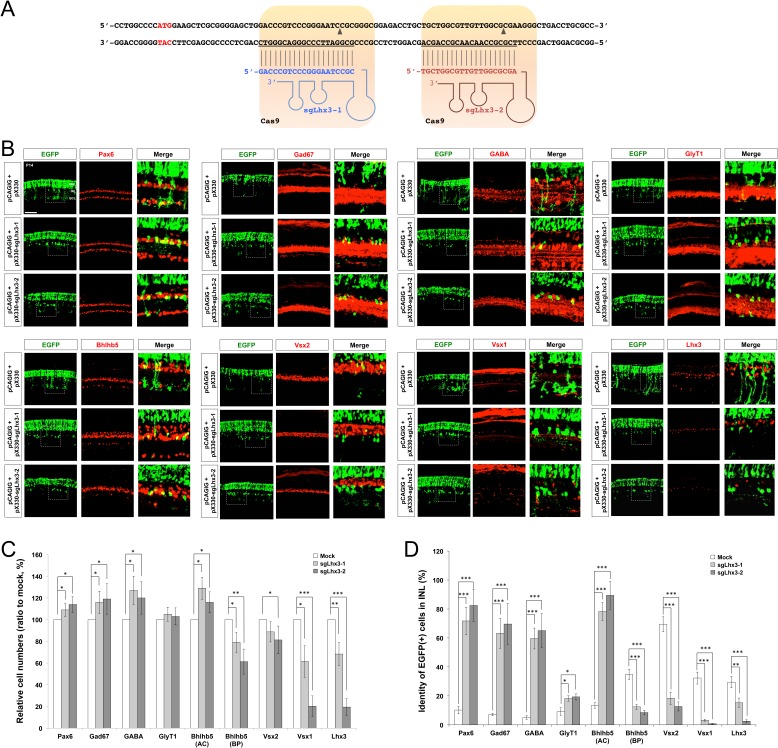
Deletion of Lhx3 in the post-natal mouse retina.(A) To delete Lhx3 in the post-natal mouse retina, we designed two independent sgRNAs complementary to the sequences near the translation initiation site in the exon2 (highlighted in red), following the suggestion of the CRISPR Design server (http://crispr.mit.edu). The sequences were cloned into pX330 (pX330-U6-Chimeric_BB-CBh-hSpCas9) DNA construct, which express the cloned sgRNA and Cas9 endonuclease. (B) P14 mouse retinas, which were electroporated with the indicated pX330 DNA constructs at P0, were stained for the detection of various amacrine cell markers, including Pax6 (pan-amacrine), Gad67 (GABAergic), GABA (GABAergic subsets), Bhlhb5 (GABAergic subsets, bottom half of the INL), and GlyT1 (glycinergic), and bipolar cell markers, including Vsx2 (pan-bipolar), G0α (ON bipolar), Vsx1 (OFF bipolar), and Bhlhb5 (type-2 OFF bipolar, top half of the INL), as well as for EGFP, which is expressed from co-electroporated pCAGIG DNA construct. Thus, EGFP-positive retinal cells are expected to express sgRNA and Cas9 from the indicated pX330 DNA constructs. Successful loss of Lhx3 in the mouse retinas was examined by immunostaing of Lhx3. Scale bar, 100 μm. (C) Ratio of marker-positive cells to total INL cells of each sample was then compared with that of pX330+pCAGIG (Mock) sample. (D) The population of EGFP-positive cells co-expressing each amacrine or bipolar cell type-specific marker in total EGFP-positive INL cells were obtained and shown in a graph. Scores on the Y-axis of the graphs in C and D are averages (n = 6, two independent batches). Error bars indicate STD (n = 6, two independent batches); *p<0.05; **p<0.01; ***p<0.001.